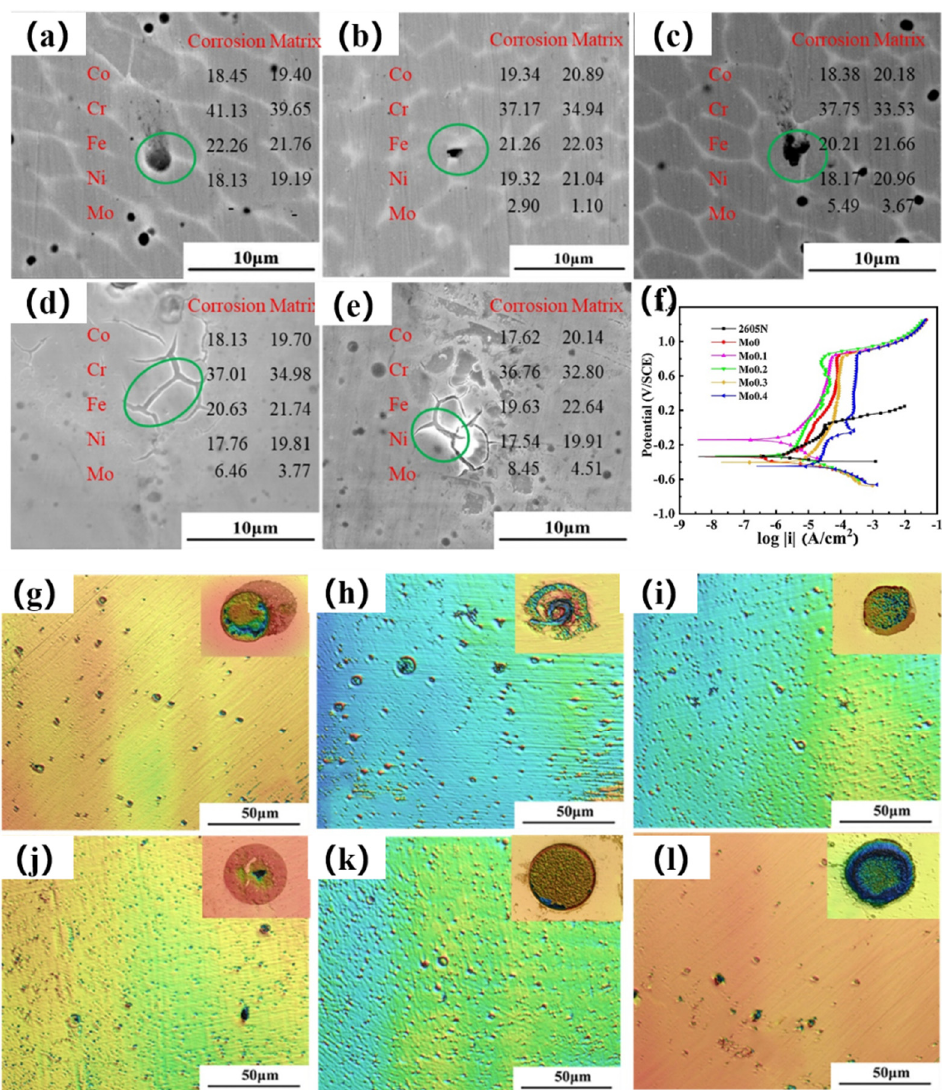
Figure 2. The local corrosion morphology of CoCr 2 FeNiMox (x = 0, 0.1, 0.2, 0.3, 0.4) HEA coatings after immersion in 10 wt.% FeCl3 solution for 10 days, ( a ) Mo 0 , ( b ) Mo 0.1 , ( c ) Mo 0.2 , ( d ) Mo 0.3 , ( e ) Mo 0.4 (the typical corrosion morphologies are highlighted in the green circles). The compositions of the corrosion region and matrix of the coatings are inserted in the corresponding images. ( f ) Potentiodynamic polarization curves of coatings on 2605 N stainless steel in 3.5% NaCl solution (pH = 2). Corrosion morphology and pitting morphology of coatings on 2605 N stainless steel at 3.0 ◦ C ( g ) 2605 N stainless ( h ) Mo0 coating ( i ) Mo 0.1 coating ( j ) Mo 0.2 coating ( k ) Mo 0.3 coating ( l ) Mo 0.4 coating (Reprinted with permission from ref. [38]. Copyright 2021